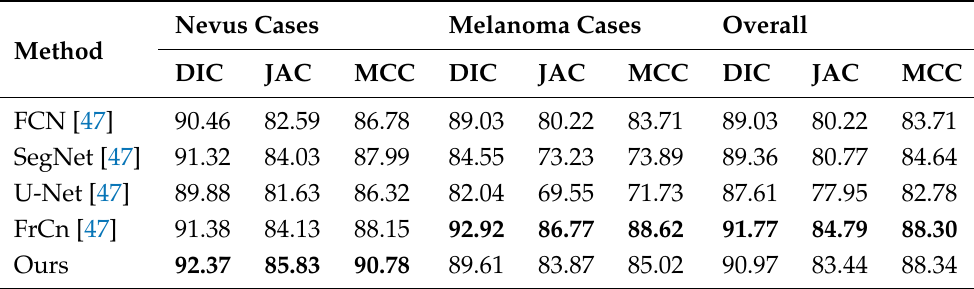
Table 13. Performance evaluation of Jaccard coefficient, Dice coefficient and Matthew correlation coefficient of different attention modules and CSFAG modules on the ISIC-2017 data set using baseline as the basic structure. Bold data indicates that the value is the maximum value in this